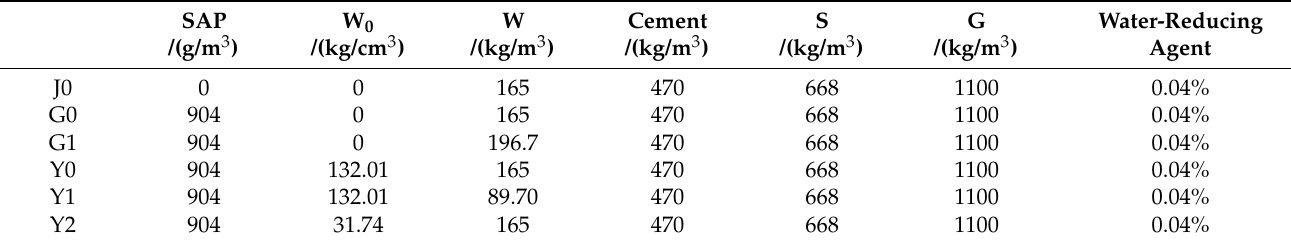
Table 2. Internally cured concrete mix